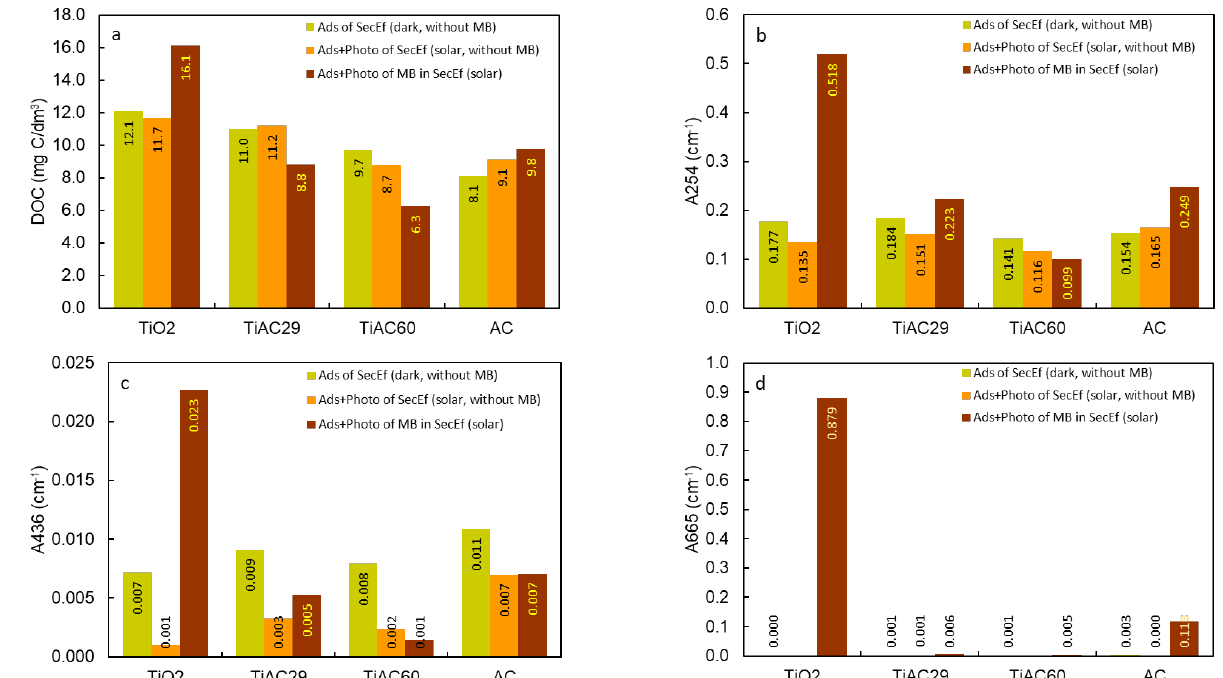
Figure 15. DOC ( a ), A254 ( b ), A436 ( c ) and A665 ( d ) of the SecEf after adsorption and adsorption+photocatalysis, and of the SecEf spiked with MB after adsorption+photocatalysis (25 mg/L MB and contact time = 90 min).